Question: Summarize what this figure shows in one sentence.
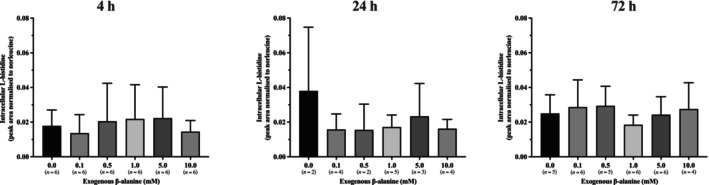
Answer: Intracellular L‐histidine in differentiated H9c2 cells after 4, 24, and 72 h of exogenous β‐alanine incubation. Data are calculated as analyte peak area normalized to the internal standard (Norleucine) peak area and presented as mean ± 1 SD. Replicate numbers included in analysis are presented underneath each respective concentration.